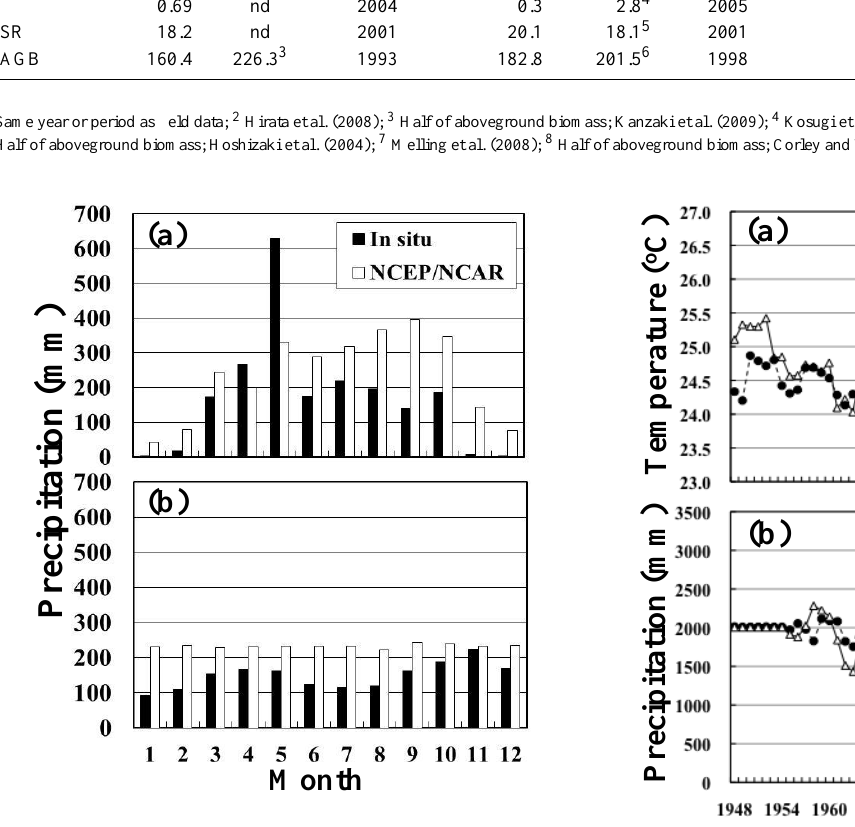
Fig. 3. Comparison of observed monthly precipitation data and that from the US National Centers for Environmental Prediction and the US National Center for Atmospheric Research (NCEP/NCAR) in (a) dry evergreen forest (DEF) from 2001 to 2003 and (b) rainforest (RF) from 1991 to 1997.